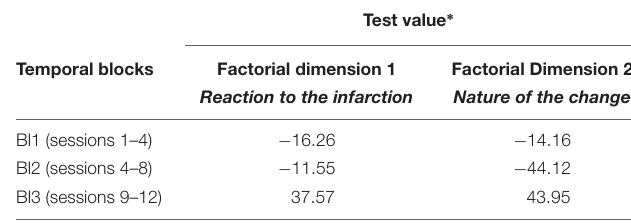
TABLE 2 | Lexical correspondence analysis output. TABLE 3 | Association factorial dimensions × Temporal